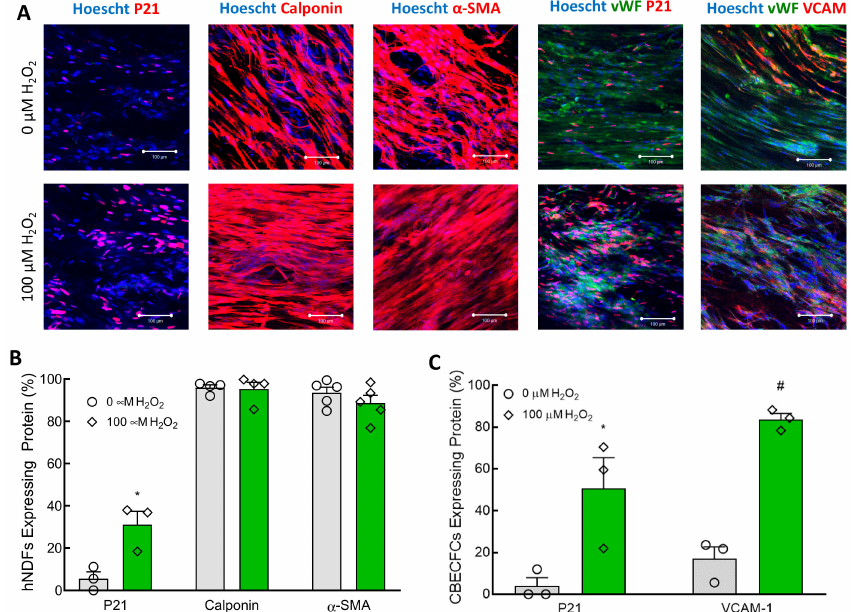
Figure 5. Seven-day treatment of TEBVs with 100 µ M H 2 O 2 caused senescence in the embedded hNDFs and ECFCs, as well as an increase in endothelial VCAM-1 expression. The treatment regime was the same as that described in Figure 4. ( A ) Immunofluorescence was used to evaluate the expression of p21, calponin, α -SMA, and VCAM in the appropriate cell types within the TEBVs. Expression of p21 and VCAM-1 was increased in TEBVs treated with 100 µ M H 2 O 2 for one week. Scale bars represent 100 µ m. ( B ) Quantification of immunofluorescent images confirmed that hNDFs encapsulated in TEBVs experienced a significant increase in p21 expression (* p < 0.05) with 100 µ M H 2 O 2 treatment, but expressions of calponin and α -SMA were not a ff ected. Values represent the mean ± SEM. N = 5. ( C ) Quantification of immunofluorescent images confirmed that treatment of TEBVs with 100 µ M H 2 O 2 significantly increased the expressions of p21 and VCAM-1 in the CBECFC monolayer (# p < 0.005). Bars represent the mean ± SEM. N = 3–5.